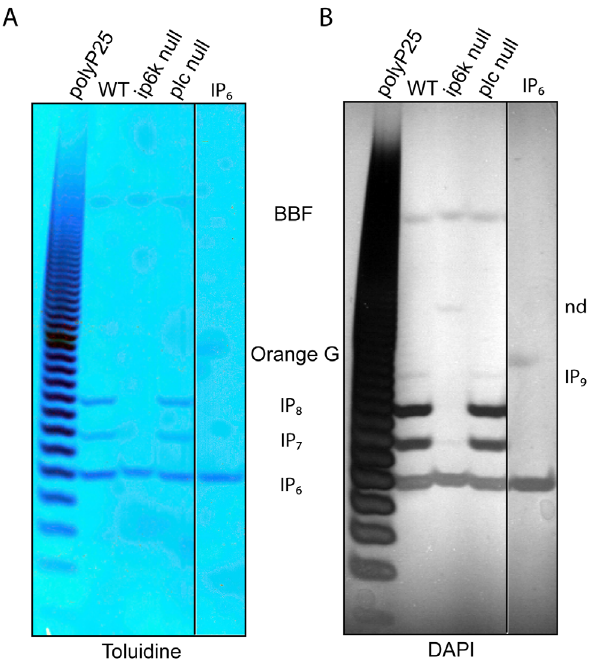
Figure 1. PAGE analysis of D.discoideum cell extract reveal the presence of three major bands. Inositol phosphates were extracted from 10 ml culture growth of wild type (WT) D. discoideum (AX2 strain) and the IP 6 -Kinase (ip6k null) and phospholipase C mutant (plc null) grown at a density of 2–4 6 10 6 . About 30–40 microliters of neutralised cell extract (equivalent to 1/20 of the total volume) was resolved on 35.5% PAGE [26] and visualized with Toluidine blue (A) and DAPI staining (B). The figure shows the result of a representative experiment that was repeated three times.